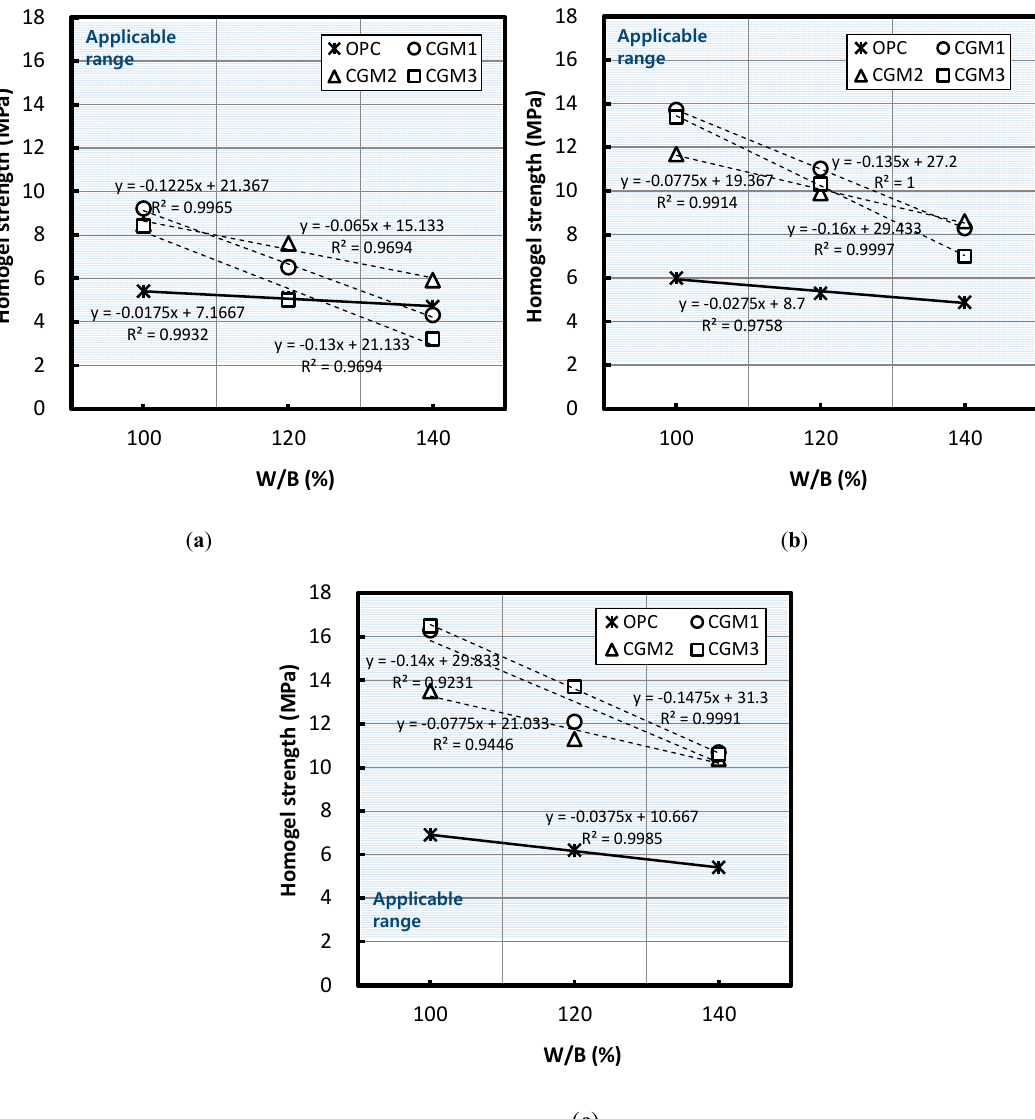
Figure 5. Homogel strength based on W/B ratio of Liquid B for a Liquid B/CLGM equal to ( a ) 50%, ( b ) 60%, and ( c ) 70%. Table 7. Estimated values of homogel strength according to W/B ratio (seven days).